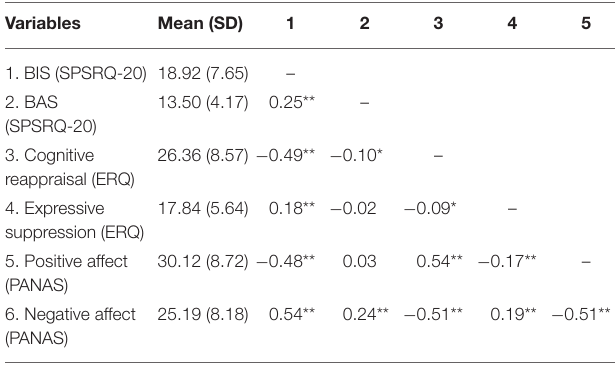
TABLE 2 | Means, Standard Deviations, and Correlations Between the Study Variables.